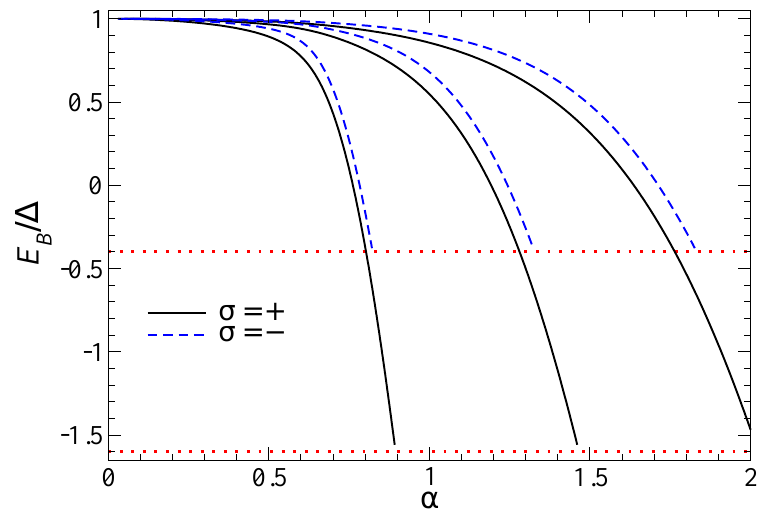
vs . Rashba SOI λ for c vs . cutoff scale R c